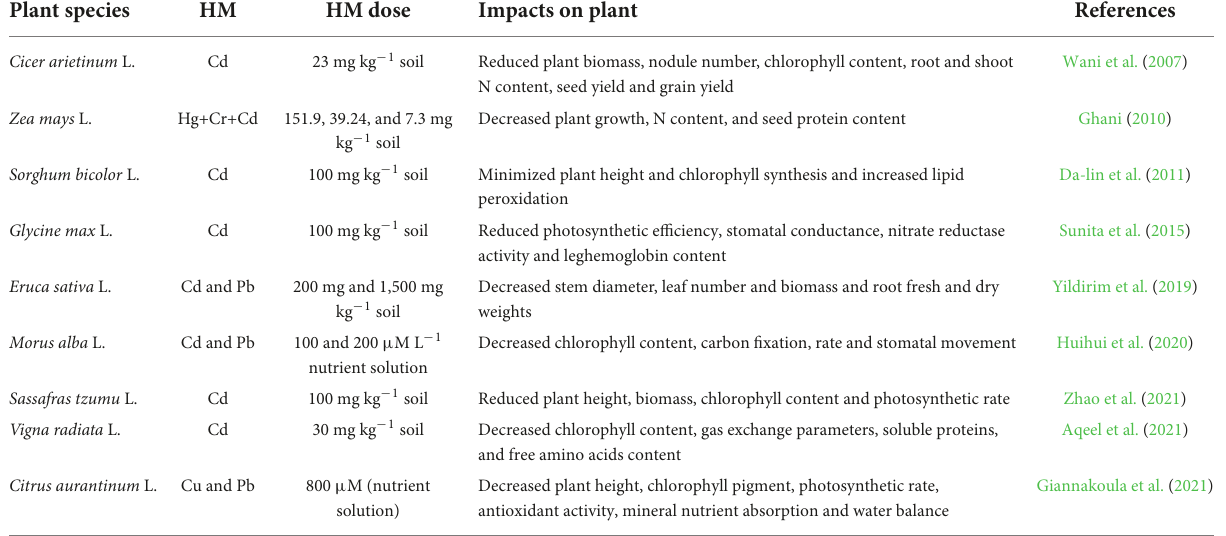
TABLE 1 Toxic effects of heavy metal (HM) stress on plant growth, physiology, and yield